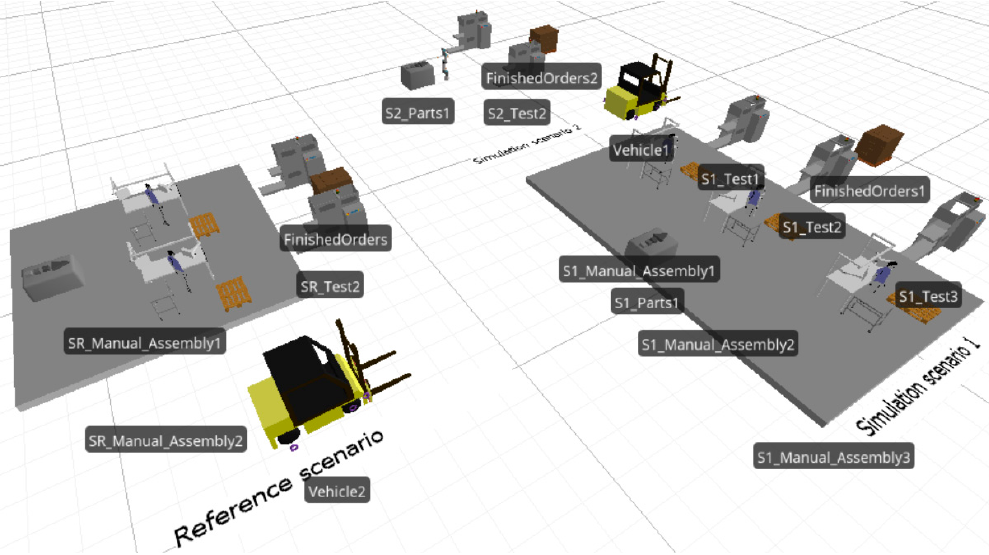
Figure 5. Data-driven simulation model in Simio presenting three simulation scenarios .